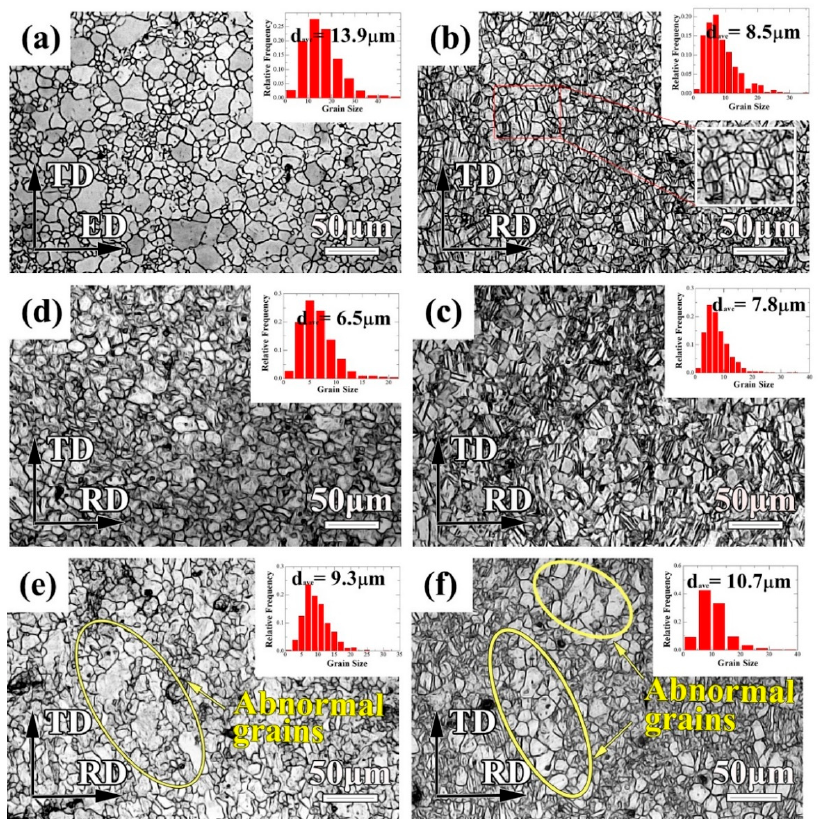
Figure 2. Optical microscopy (OM) of ATM610 alloy sheet at different conditions: ( a ) extruded sample, ( b ) as-rolled sample, ( c ) as-rolled sample annealed at 250 ◦ C for 10 min, ( d ) as-rolled sample annealed at 250 ◦ C for 30 min, ( e ) as-rolled sample annealed at 250 ◦ C for 60 min, and ( f ) as-rolled sample annealed at 250 ◦ C for 120 min. Crystals 2018 , 8 , x FOR PEER REVIEW